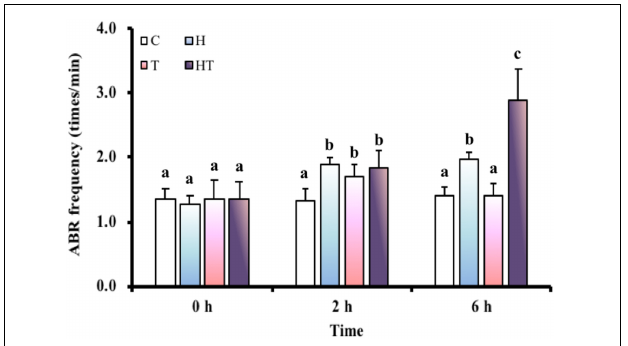
FIGURE 1 | ABR frequency ( n = 8–12) of M. opercularis in control (C), hypoxic (H), thermal (T), and hypoxic-and-thermal (HT) treatments at 0, 2, and 6 h. Values that were significantly different ( p < 0.05) among treatments and times are indicated by lowercase letters. Data are presented as mean ± SEM.